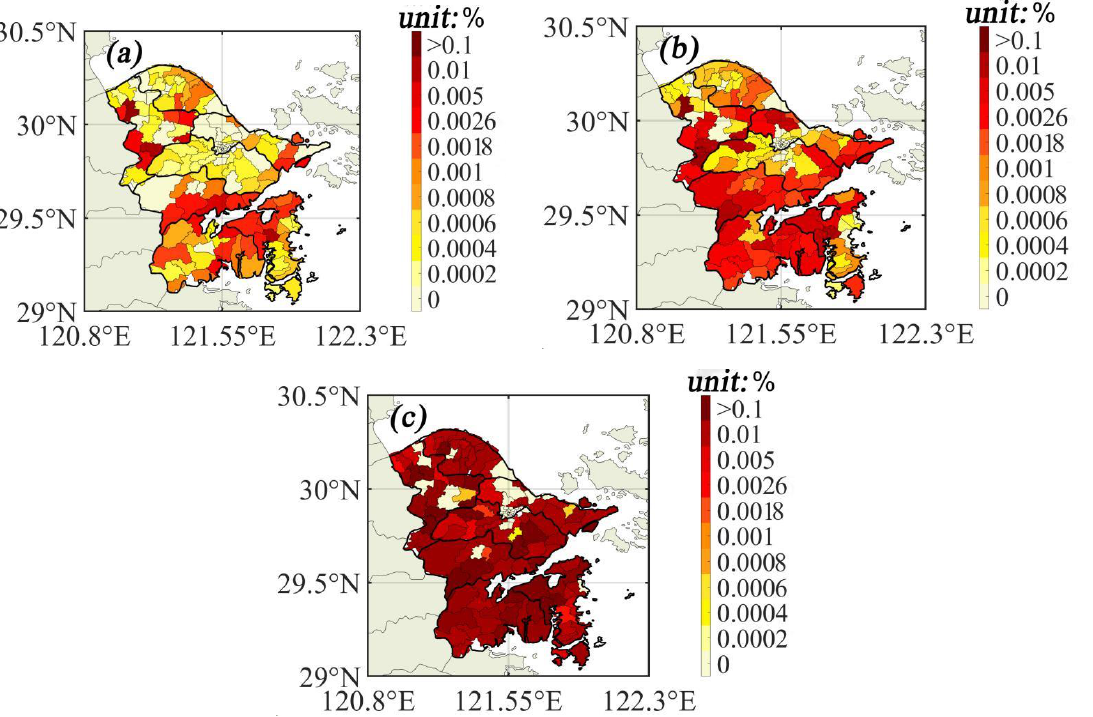
Figure 15. RBF neural network prediction results. ( a ) Loss rate under the design wind speed of 10 year return period (21.9 m/s); ( b ) Loss rate under the design wind speed of 50 year return period (28.3 m/s); ( c ) Loss rate under the design wind speed of 100 year return period (31.0 m/s).